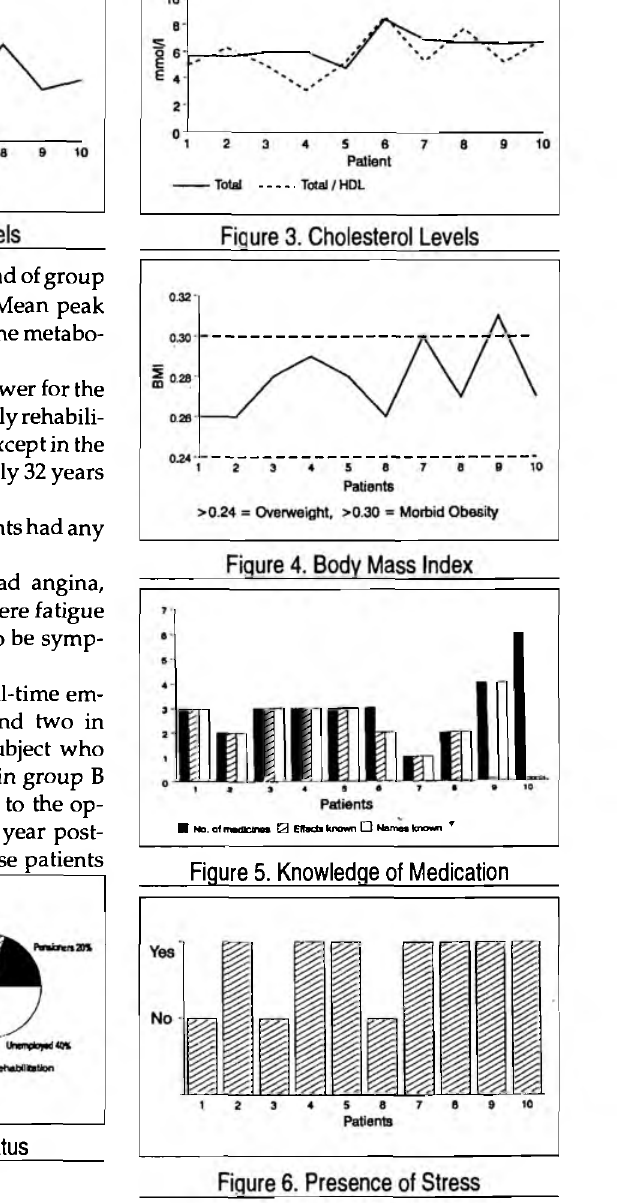
Figure 2. Employment Status